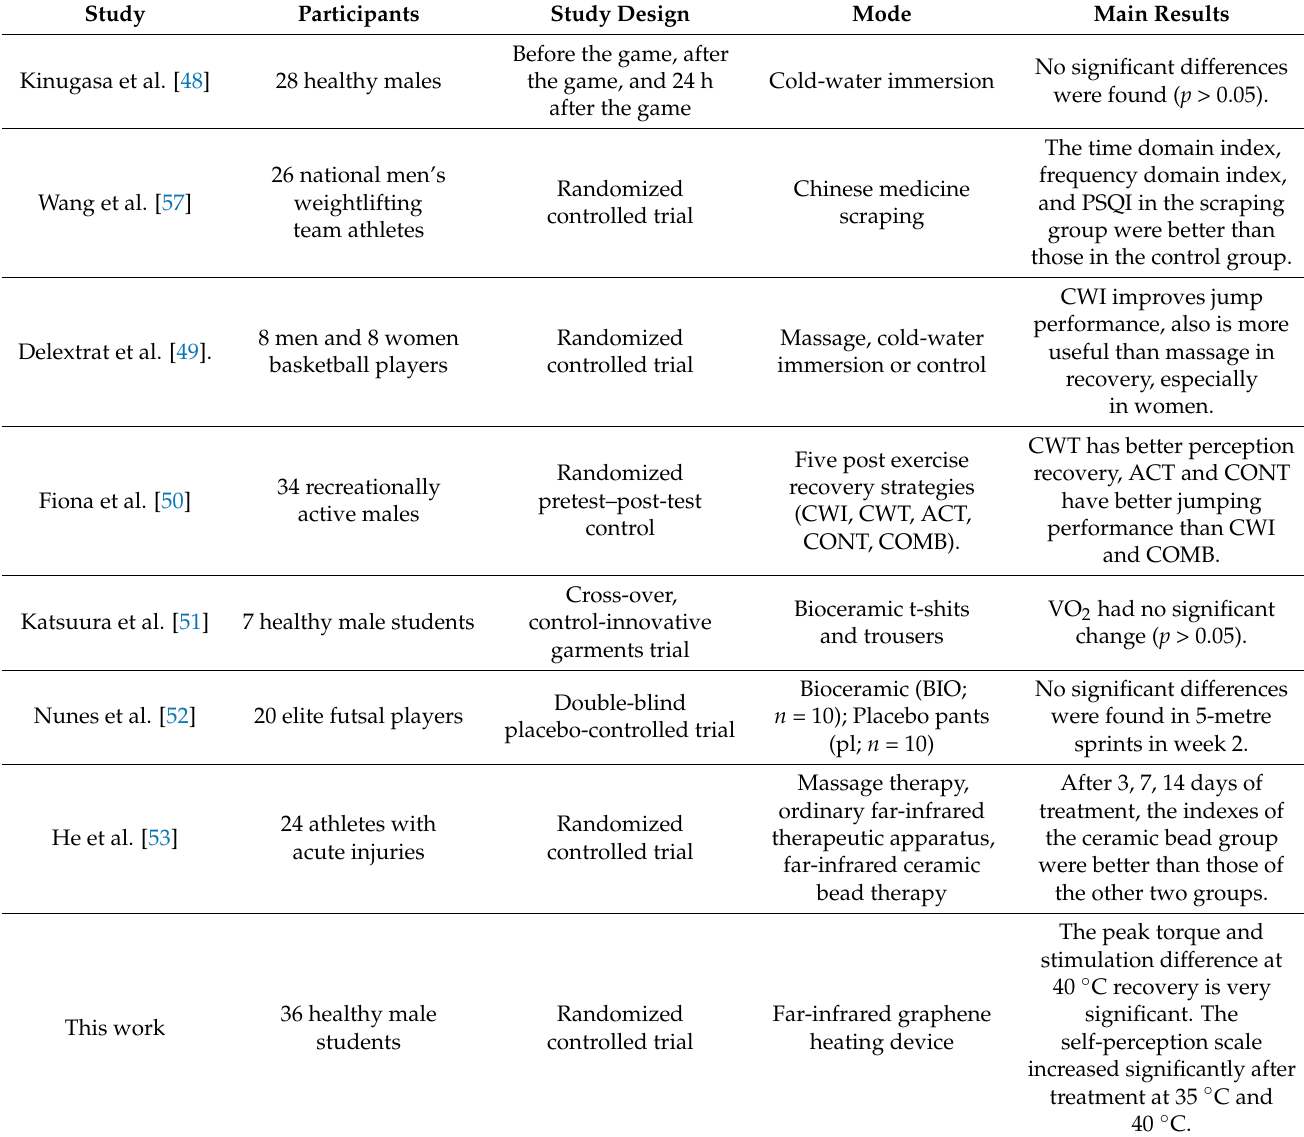
Table 7. Comparison of effects of different fatigue recovery